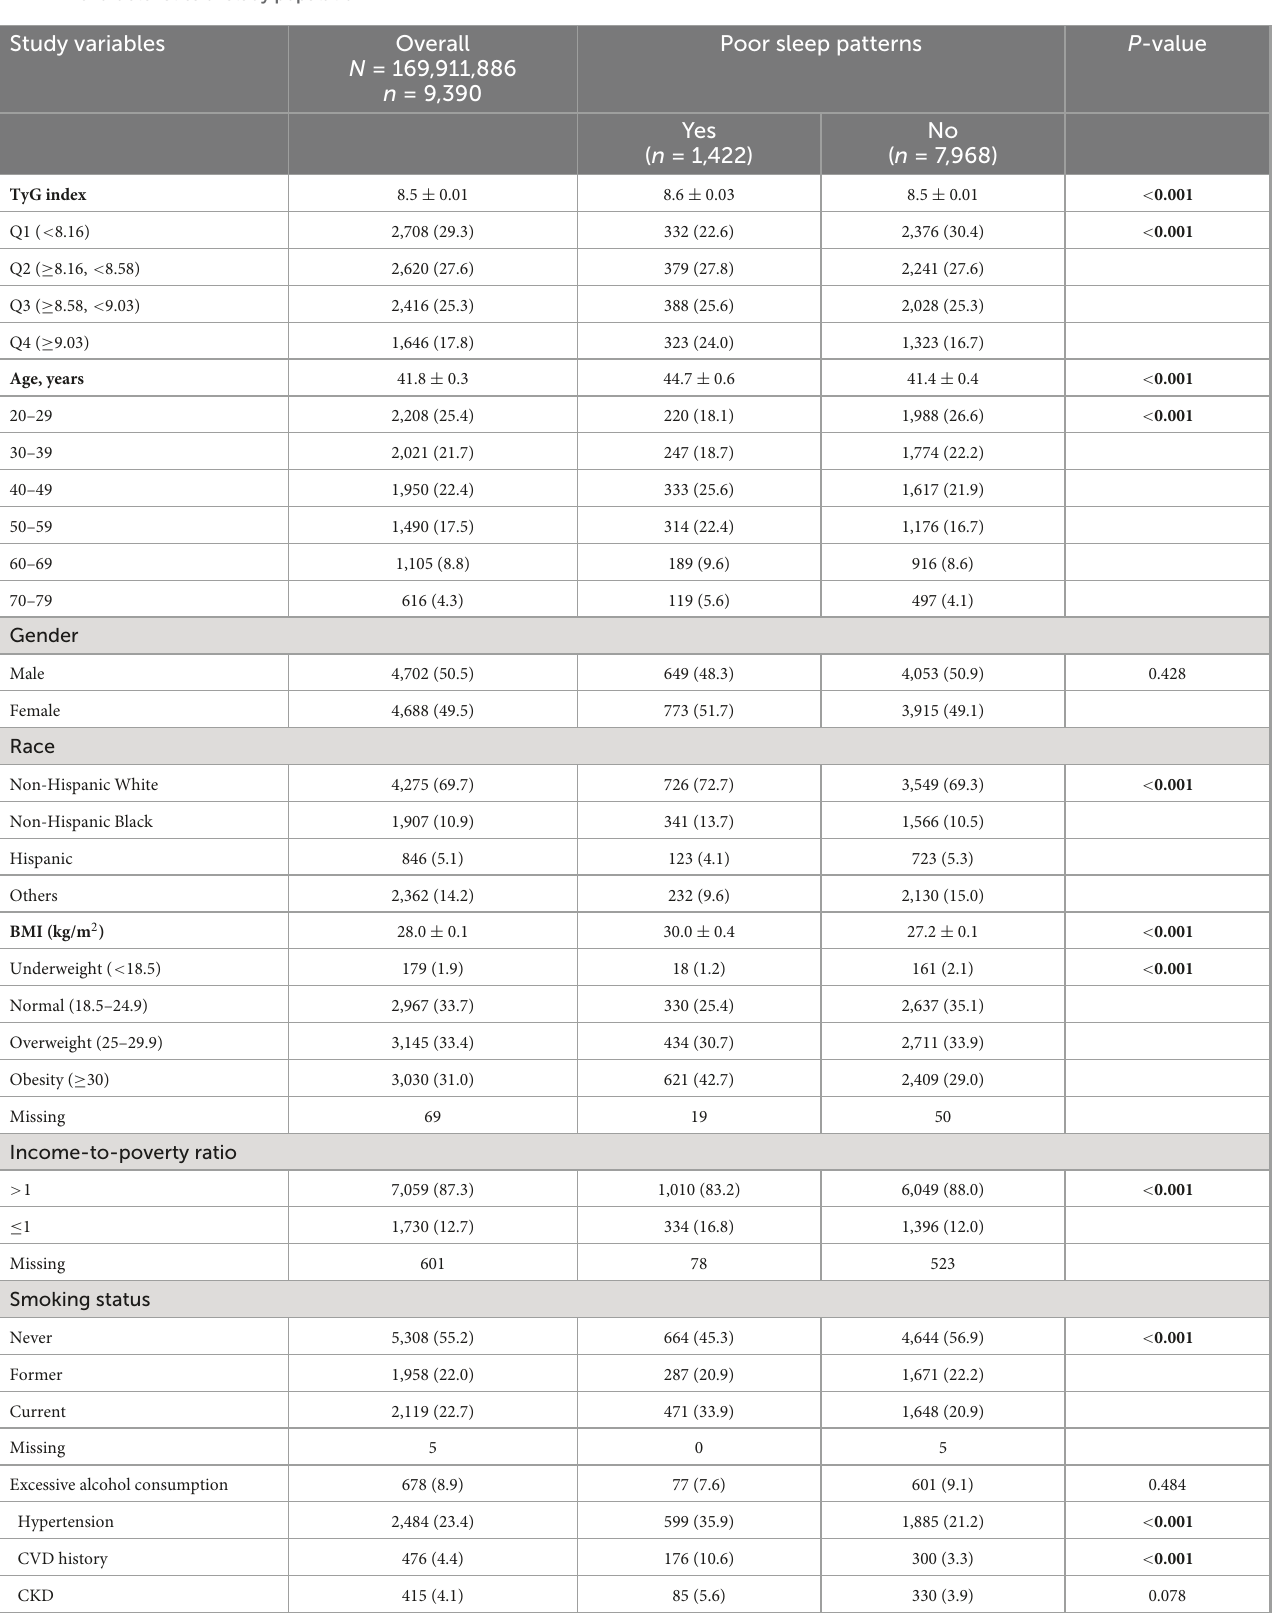
TABLE 1 Characteristics of study